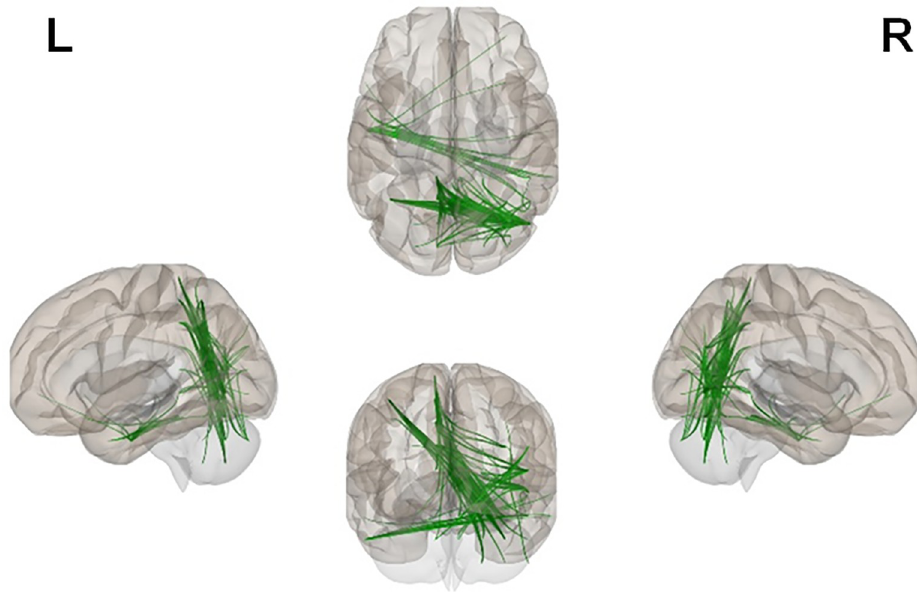
Fig 2. A comparison in functional connectivity between the dialogic reading and screen stories groups (screen > dialogic reading). The screen stories group showed a single cluster of increased posterior functional connectivity during stories listening. Findings from NBS analyses; 5,000 permutations, P < 0.05, at initial thresholds of t = 2 through 4 at increments of 0.2. Shown here, the cluster of increased connectivity at t = 3.2. (Neurological orientation, L = left, R = right).